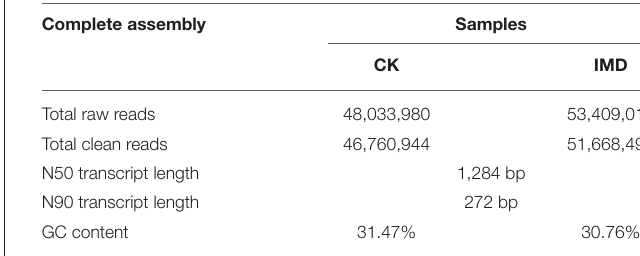
TABLE 2 | Assembly summary of the A. gifuensis